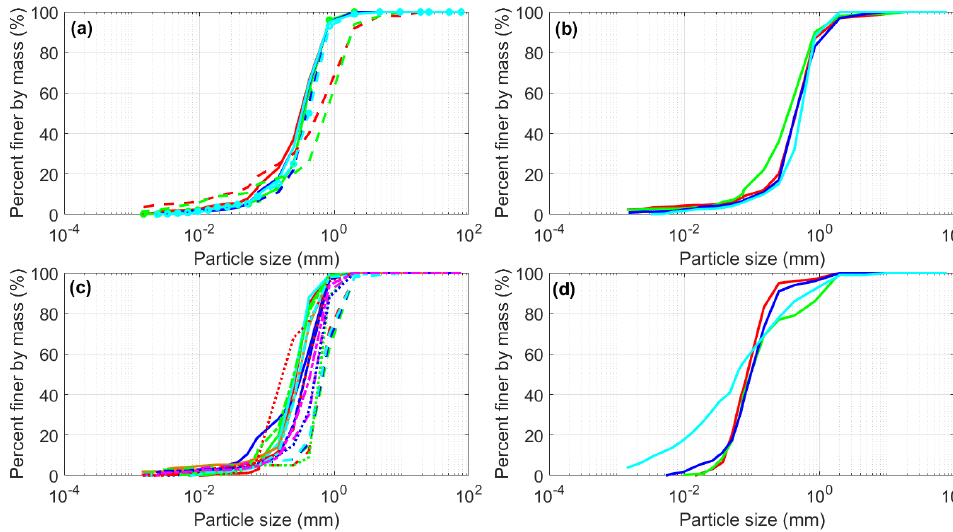
Figure 2. Particle size distribution (PSD) for (a) LFH, (b) peat, (c) subsoil, and (d) LOS materials for the treatment covers (OKC, 2009). The lines in the subplots show PSDs for different samples collected from the LFH, peat, subsoil, and LOS layers,